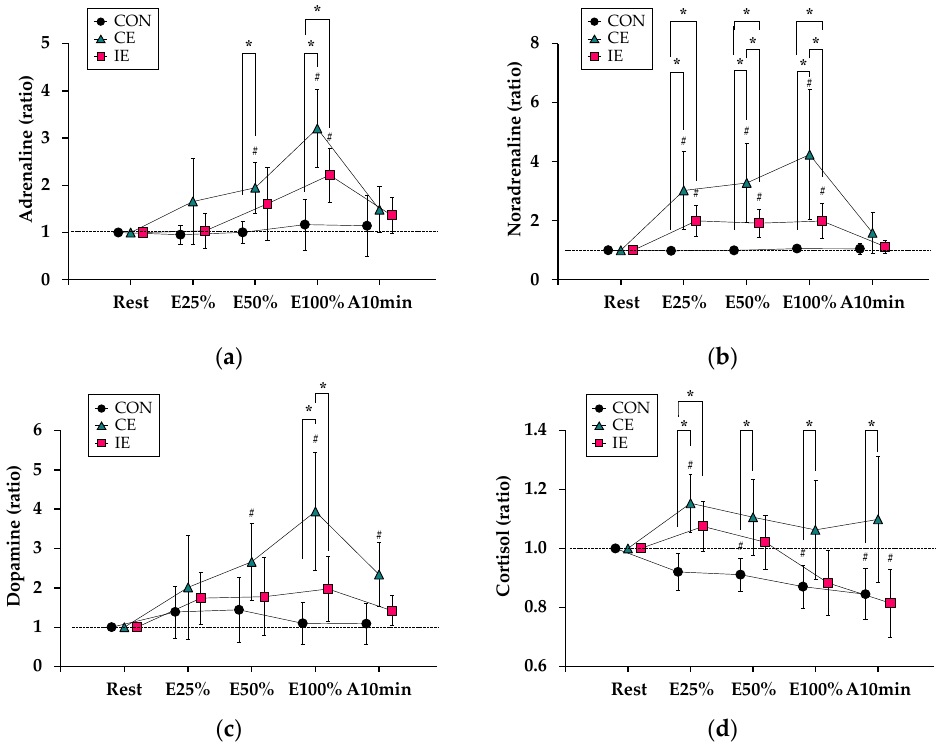
Figure 3. Responses of variables related to additional degree of exhaustion (additional biomarkers): Relative changes of ( a ) adrenaline, ( b ) noradrenaline, ( c ) dopamine, and ( d ) cortisol are shown. The circle, triangle, and cube indicate the control (CON), continuous exercise (CE), and intermittent exercise (IE) values relative to those at Rest, respectively. *: p < 0.05 indicates [type]. #: p < 0.05 indicates [time] with Rest.